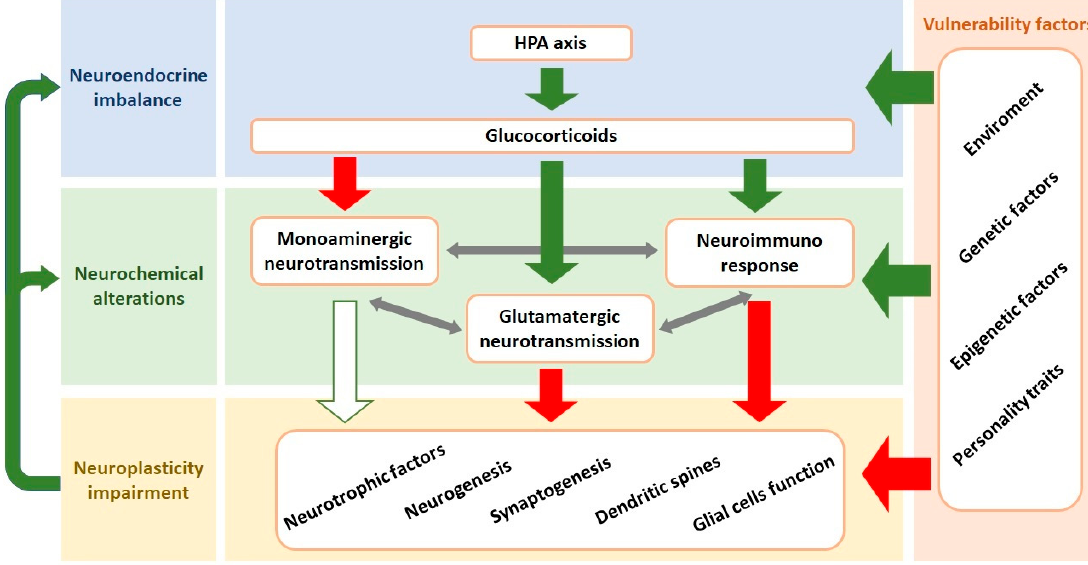
Figure 1. Interaction between the components involved in the neurobiology of MDD. Vulnerability factors can lead to development of MDD due to induction of changes in the central nervous system including the neuroendocrine homeostasis, neurochemical alterations, and neuroplasticity impairment. ThecoreresponsetostressistheHPAaxisactivationresultinginhighcirculatinglevelsofglucocorticoids. This endocrine response leads to neuroimmune activation, inhibition of monoaminergic and facilitation of glutamatergic neurotransmissions. These systems interact, and the overall result is impairment of the neuroplasticity in cortical and limbic structures. Neuroplasticity alterations include decreased levels of neurotrophic factors (e.g., BDNF), dendritic atrophy, diminished neurogenesis and synaptogenesis and glial cells dysfunction. Impaired neuroplasticity further contributes to neurochemical imbalances. Green arrows indicate stimulation while red arrows represent inhibition. White arrow with green border means that a stimulating action was blocked. HPA: hypothalamic-pituitary-adrenal; BDNF: brain-derived neurotrophic